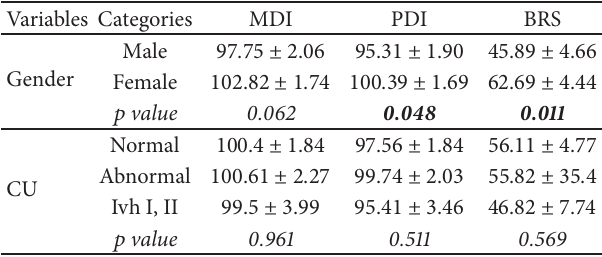
Table 4: Effects of other demographic and clinical variables (quali- tative variables) upon outcome